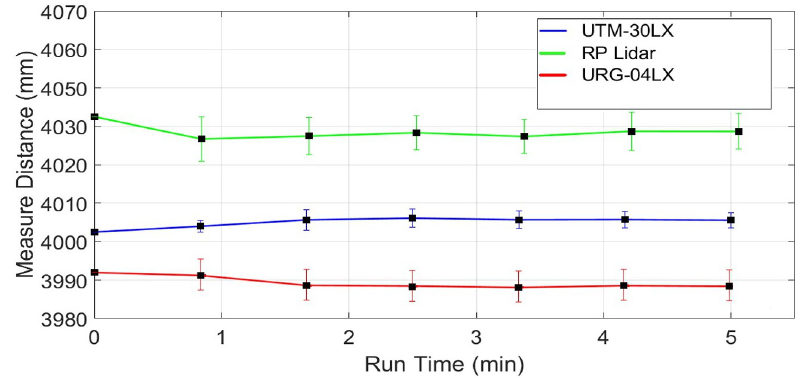
Fig 21. Plot of mean and standard deviations values for blue color object.